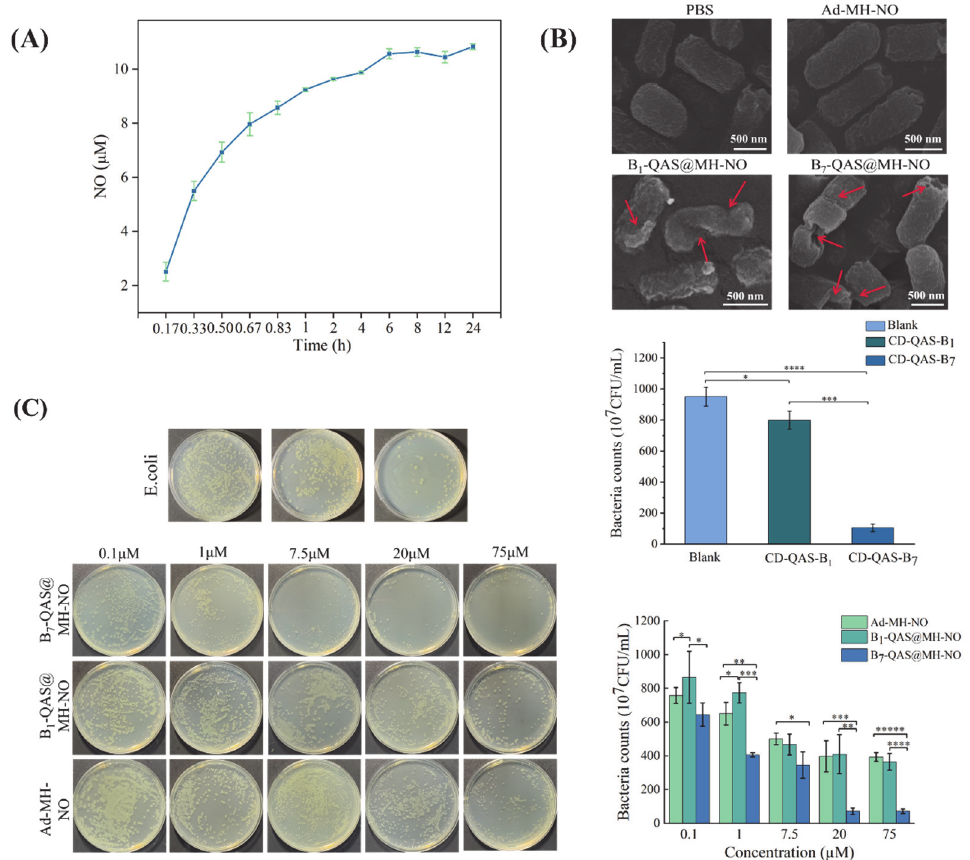
Figure 6. ( A ) The release of NO at 37 °C in PBS (pH 7.4) ( B ) SEM images of bacteria treated with different materials (red arrows indicate that the bacterial cell membrane was damaged) ( C ) Surviving colonies of bacteria on solid agar plates after interaction with PBS, CD ‐ QAS ‐ B 1 , CD ‐ QAS ‐ B 7 , B 7 ‐ QAS@MH ‐ NO, B 1 ‐ QAS@MH ‐ NO, Ad ‐ MH ‐ NO and its quantitative analysis. * p < 0.05, ** p < 0.01, *** p < 0.001, **** p < 0.0001, ***** p < 0.0001.